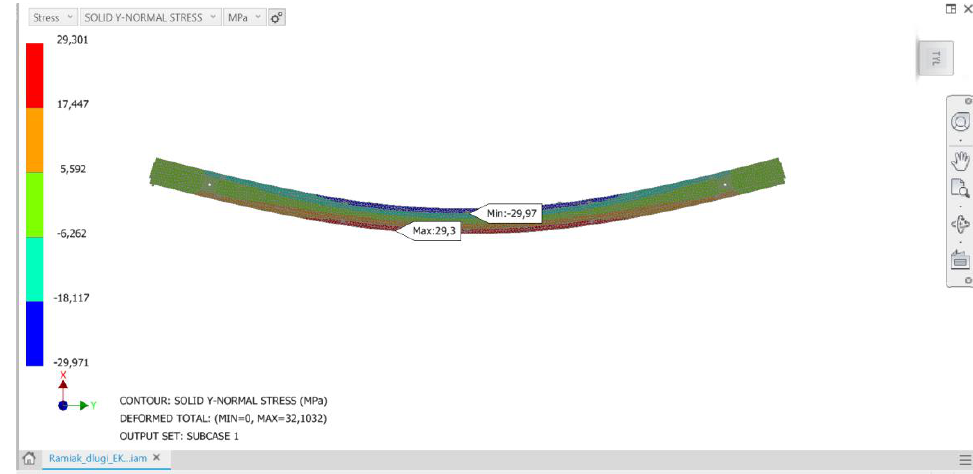
Figure 7. Mesh (computational) model of a C-version long frame made of glued material with a finger-jointed lamella length of 400 mm, along with the distribution of the normal stress map.